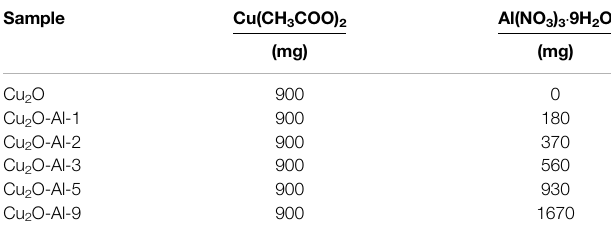
TABLE 1 | Preparation of materials with various ratios of Cu and Al